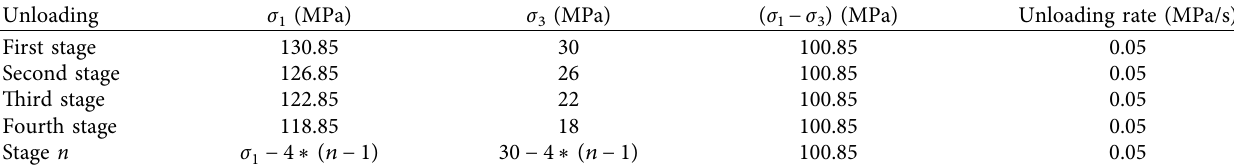
Table 2: Stress path of unloading confining pressure with constant σ